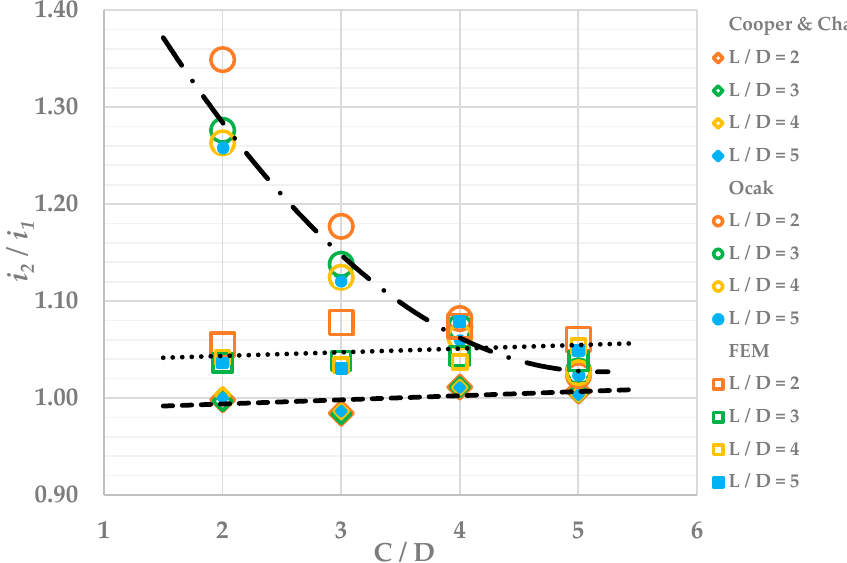
Figure 11. Trough width parameter ratio i 1 /i 2 for different methodologies.